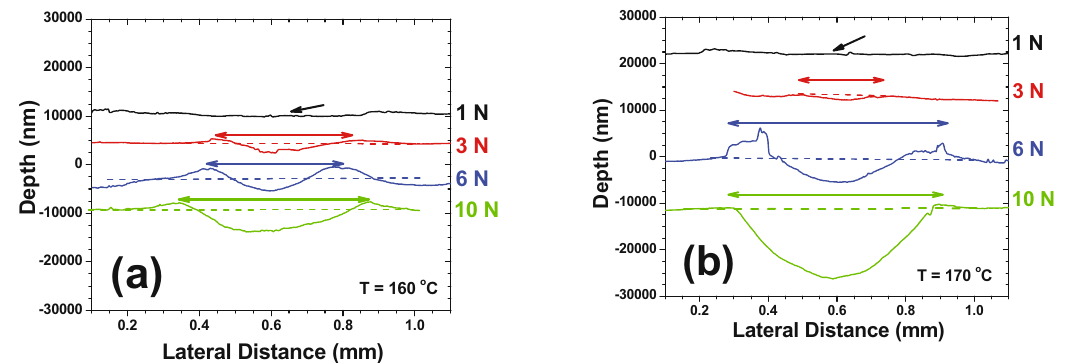
Figure 6: Pro fi le of wear tracks at di ff erent loads for ( a ) sample made at 160°C and ( b ) 170°C. Wear tracks are perpendicular to the textured lines of the surface.